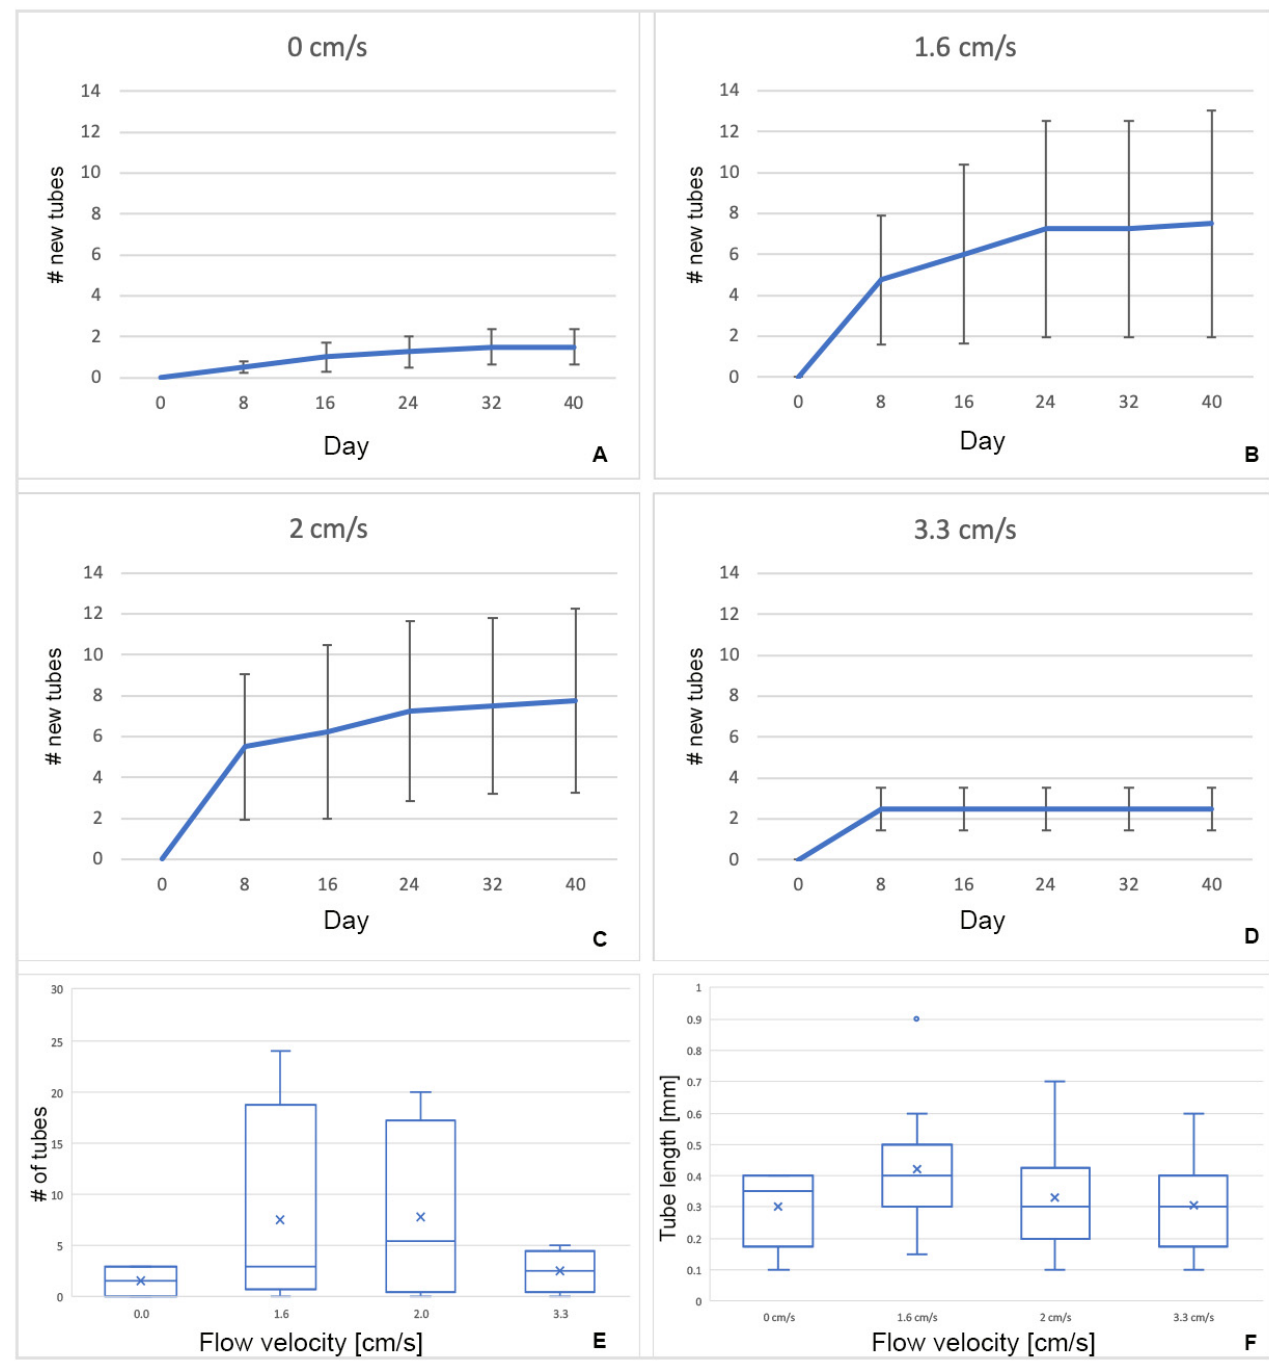
Figure 10. The number of re-secreted tubes and tube length with respect to flow velocity. ( A – D ), a plot for each treatment. On the abscissa, the days, on the ordinate, the mean number of new tubes re-secreted with error bar. ( E ) The number of tubes re-secreted as a function of the flow velocity. ( F ) The length of tubes re-secreted in the function of flow velocity. Each box delimits the distance between the first and third quartile, the median is the horizontal bar in the box, and the “×” is the mean value. The whiskers reach the lowest and largest data points, excluding the outliers (dot).